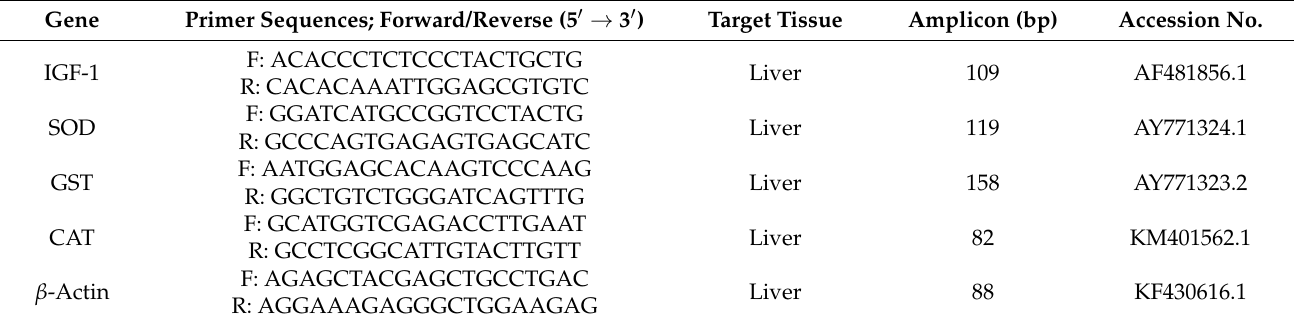
Table 3. Primer pair sequences of the genes used for quantitative real-time PCR in juvenile black rockfish ( Sebastes schlegelii